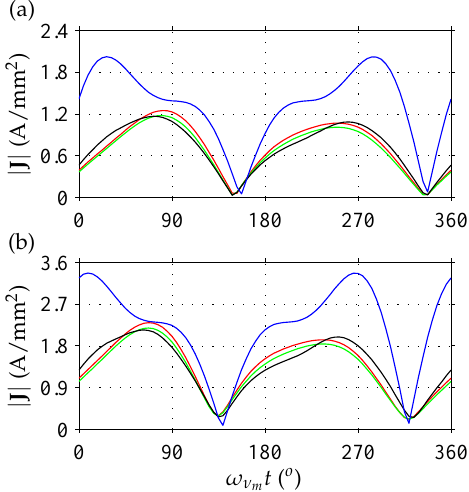
Figure 11. J evaluated at 15,000 rpm for Model A (blue lines), Model B (red lines), Model C (green lines), and 3D-FEM model (black lines) at selected points: ( a ) ’Pa’; ( b ) ’Pb’.